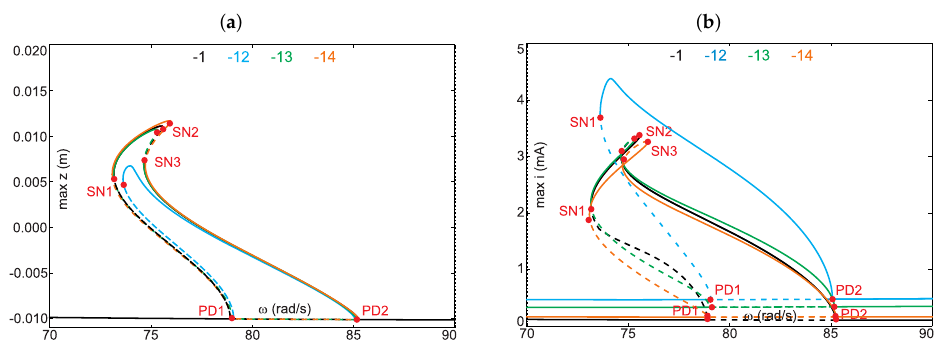
Figure 9. Comparison of the frequency response of the maximum magnet displacement ( a ) and the maximal induced current ( b ) when the active coil module is changed. The analysis was performed in the second resonance. The SN point denotes saddle-node